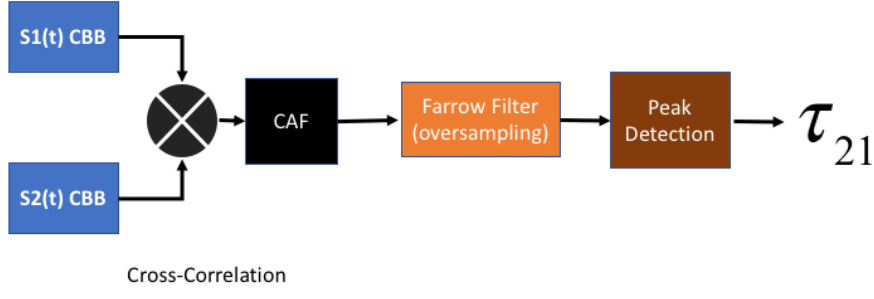
Figure 1. TDOA Estimation based on the Complex Baseband (CBB) signals arriving at Sensors 1 and 2.